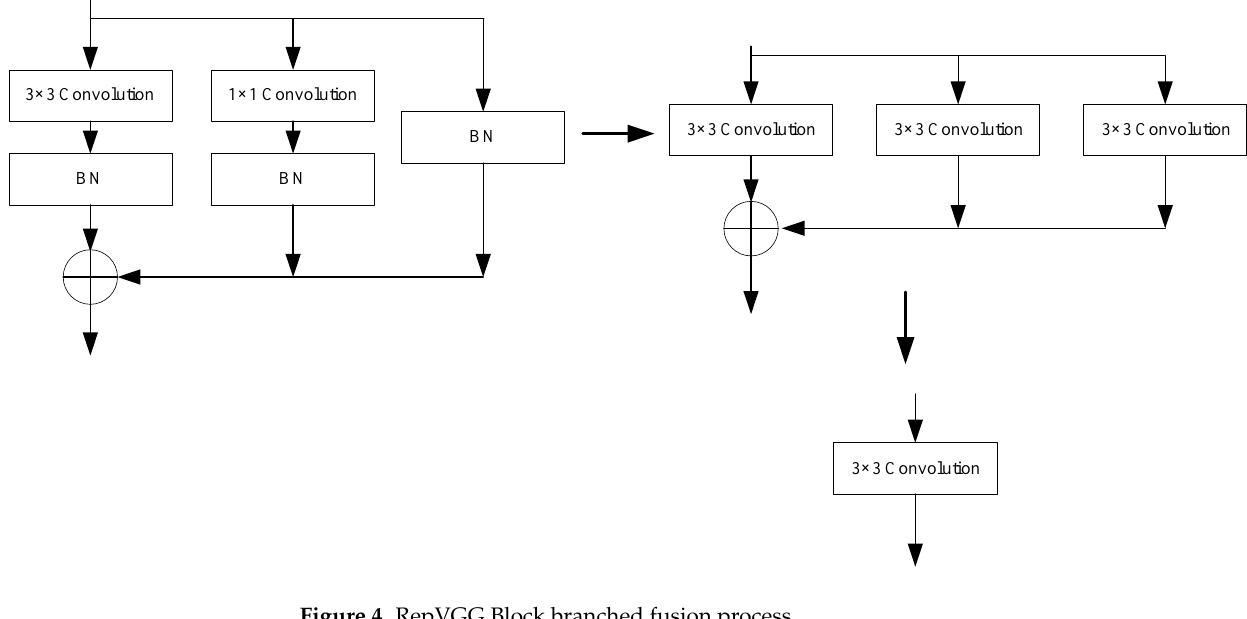
Figure 4. RepVGG Block branched fusion process.